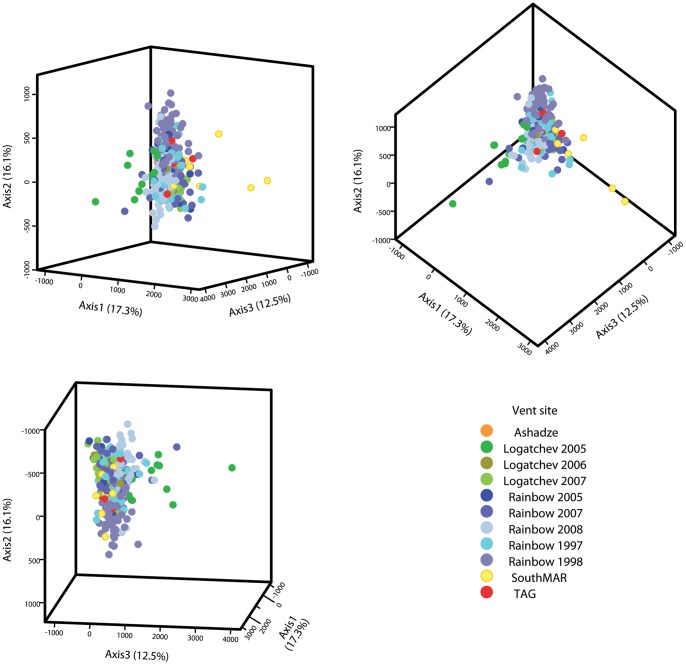
FCA plot.Three dimensional plot (presented from three different angles) of the factorial correspondence analysis for all sampled sites along the Mid-Atlantic Ridge and all sampling dates. Based on 11 microsatellite loci.